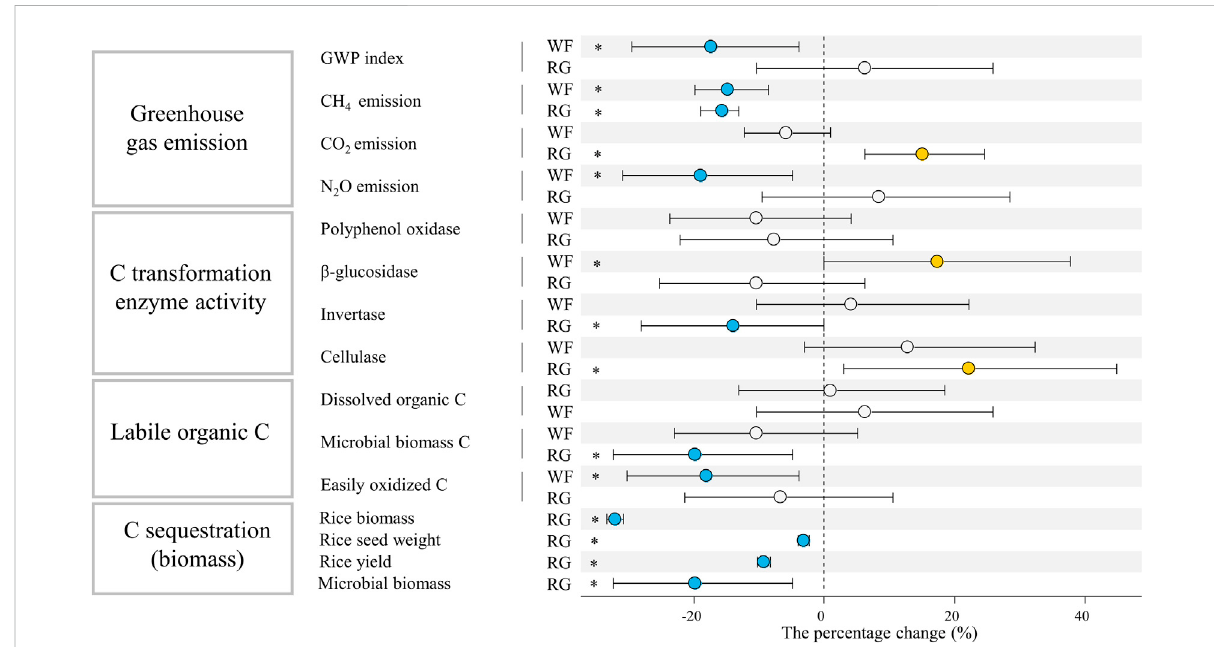
FIGURE 4 All dots represent the percentage change (%) of each variable at 95% con fi dence intervals (CIs), due to enhanced UV-B treatment when compared to exposure to natural conditions (Eq. 4). Mean values < 0 indicate, comparative to the natural condition, reductions in corresponding variables due to enhanced UV-B (blue dots), while mean values > 0 re fl ect signi fi cant increments due to enhanced UV-B treatment (yellow dots). When error bars intersect the zero line, these indicate no signi fi cant differences between the effects of enhanced UV-B treatment and results occurring under natural conditions (white dots). WF: in the winter fallow period; IR: in the rice-growing period. All signi fi cant differences have been marked with